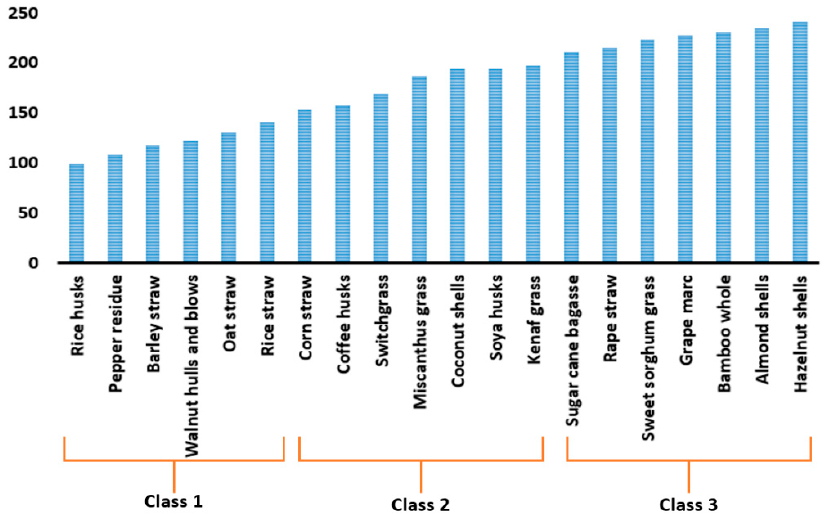
Figure 2. Specific mass flow rate of bioethanol from 20 H&AB gasification systems (gasifier temperature of 900 °C and air-to-fuel ratio of 2).